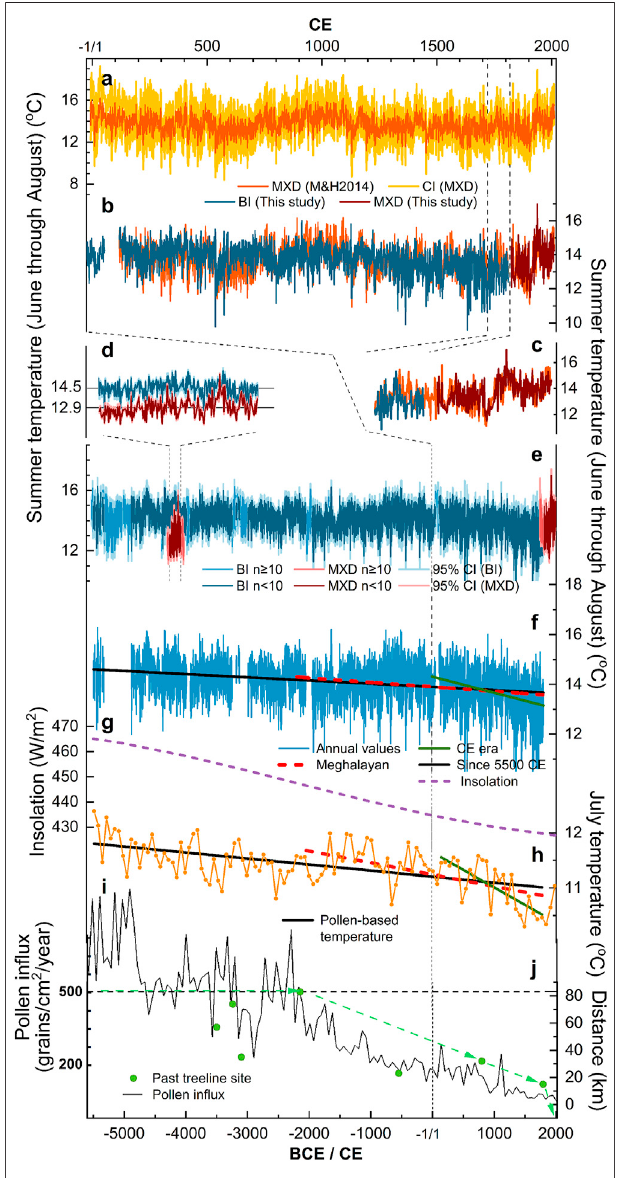
FIGURE 4 | species. (J) Past tree-line sites showing the phytogeographical data(Seppäetal.,2002;Helamaetal.,2004bthisstudy)withevidenceforthe last presence of P.sylvestris in the studied sites relative to the modern tree line position in northwest Finnish Lapland (for site locations, see Figure 1A